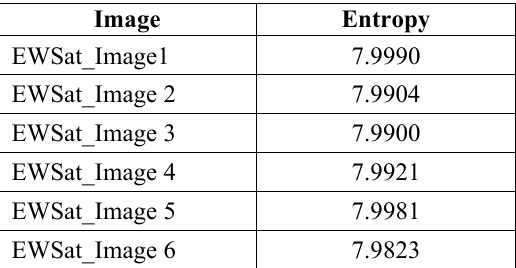
Table 2. Entropy of Encrypted Raster Data